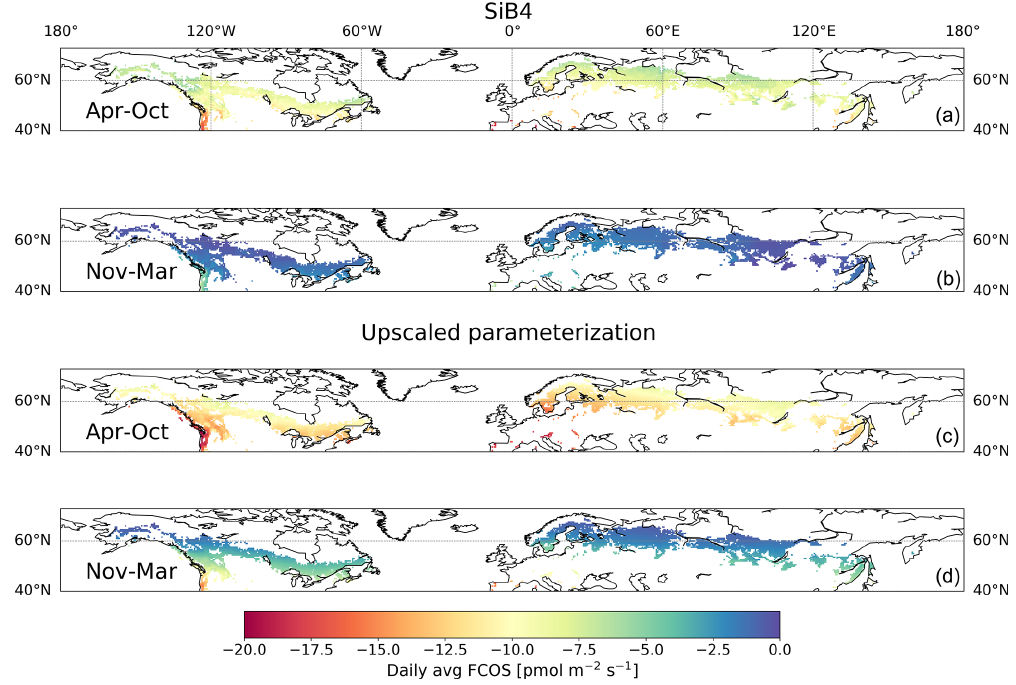
Figure 7. Daily average (avg) carbonyl sulfide flux (FCOS) in the boreal region based on SiB4 (a, b) and upscaled parameterization simula- tions (c, d) for the April–October and November–March periods. The boreal region is defined as the area where evergreen needleleaf forests cover more than 30% of the land area in the Northern